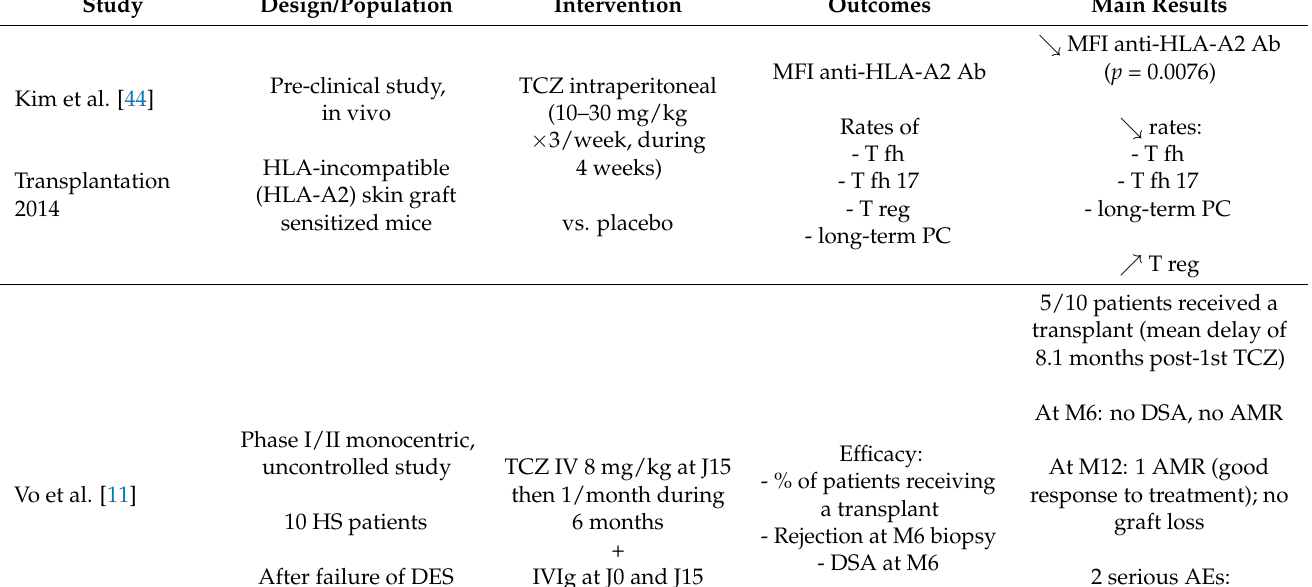
Table 1. Key safety and efficacy studies using tocilizumab as a desensitization therapy. Study Design/Population Main